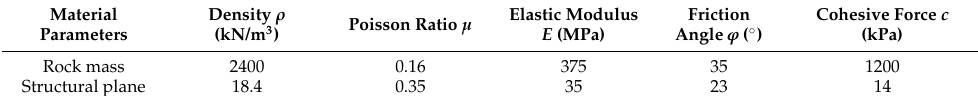
Table 1. Physico-mechanical parameters of material parameters of the slope.